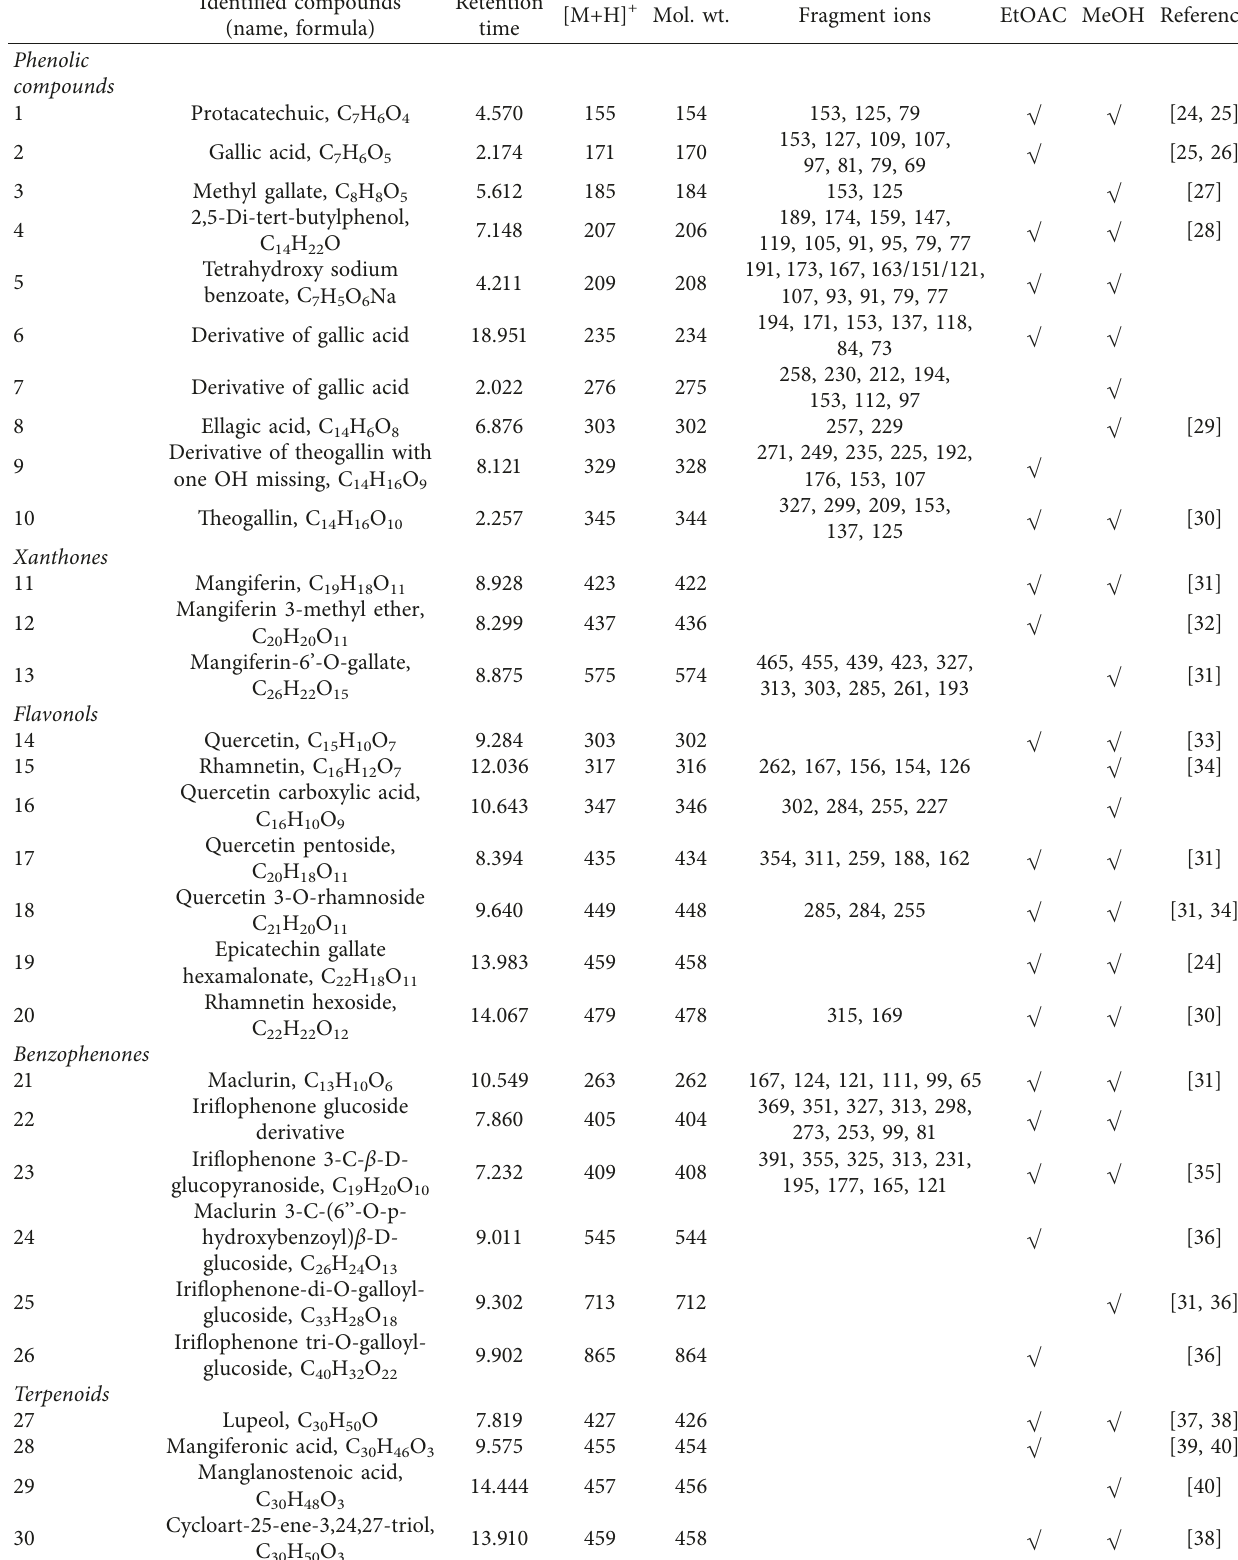
Table 3: Compounds determined by UPLC-MS/MS in the EtOAc and MeOH extracts of Mangifera indica in the positive-ion mode. Identified